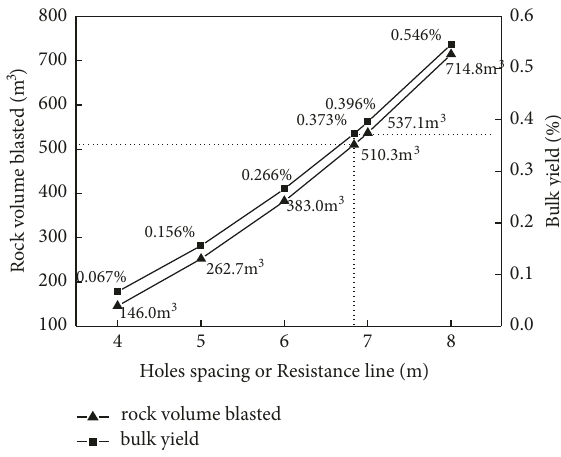
Figure 20: The blasting quality of square patterns.